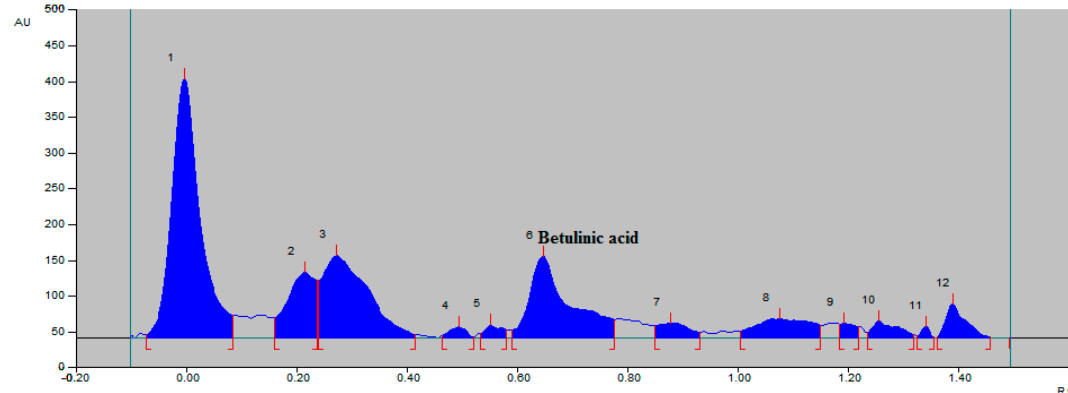
Figure 3. HPTLC chromatogram of BA in hexane extract of Tecomella undulata bark. Table 1. Densitometric validation summary of betulinic